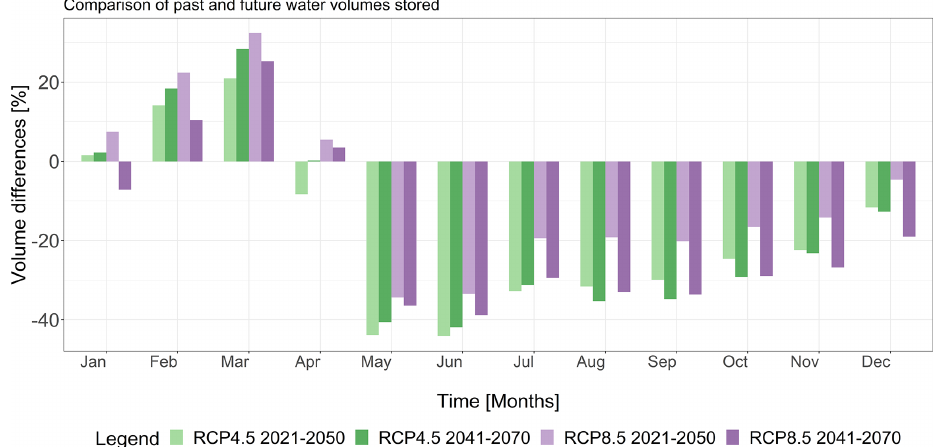
Figure 7. Percentage change of volume [%] comparing the four climate scenarios to the baseline at a monthly level. For an interpretation of the references to colour in this figure legend, the reader is referred to the web version of this